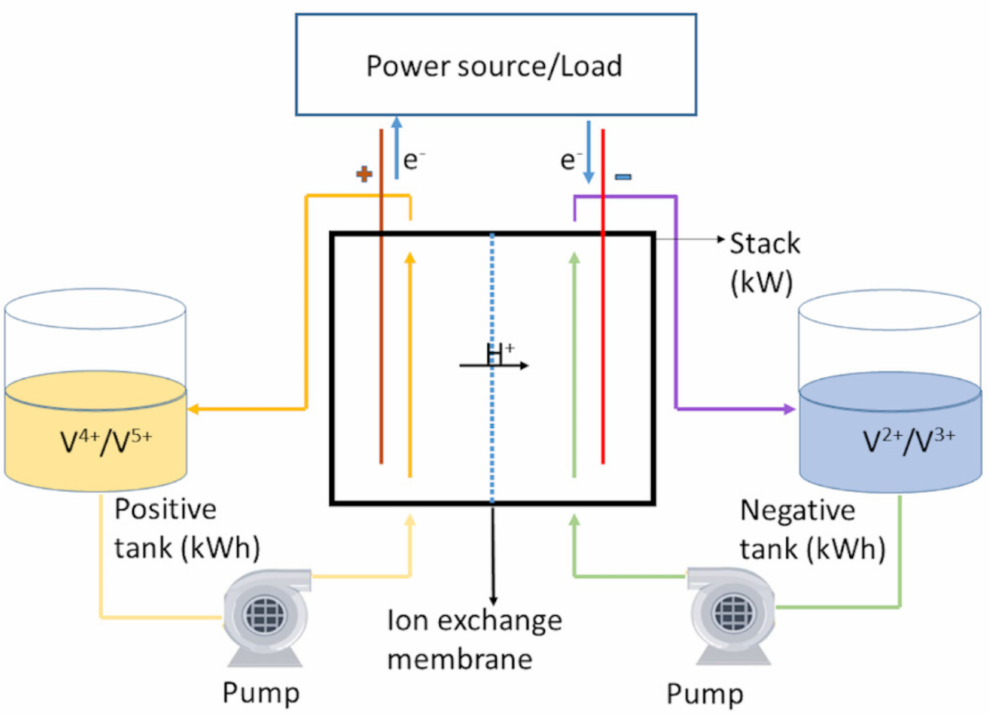
Figure 1. Schematic diagram of